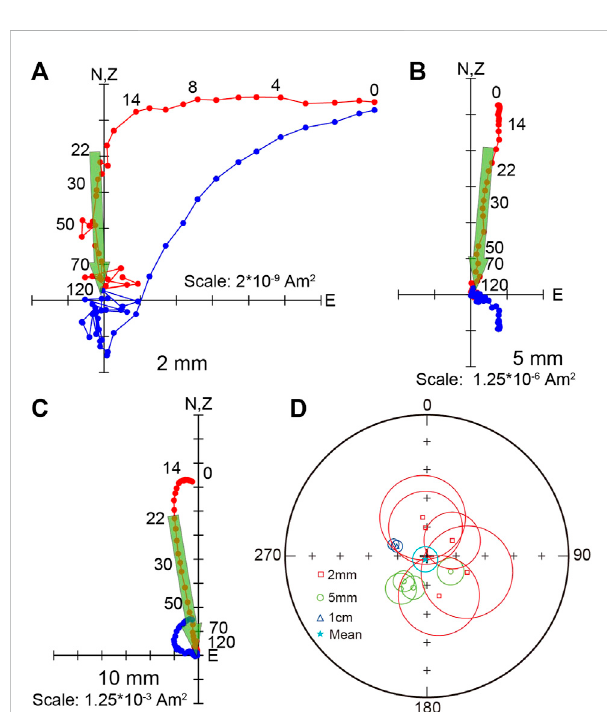
FIGURE 8 Typical orthogonal vector plots of AFD results of (A) 2-mm side length specimen, (B) 5-mm side length specimen and (C) 10-mm side length specimen. Magnetic directions are plotted in core coordinates for representative specimens. Blue/red circles represent vector endpoints projected onto the horizontal/vertical plane. Numbers on the plots show AFD steps in mT. (D) Equal-area projections of the paleomagnetic directions of the characteristic remanent components. Red, green and blue circles around each symbol represent MADs of each specimen. The cyan circle represents α 95 of fi sher mean of all the